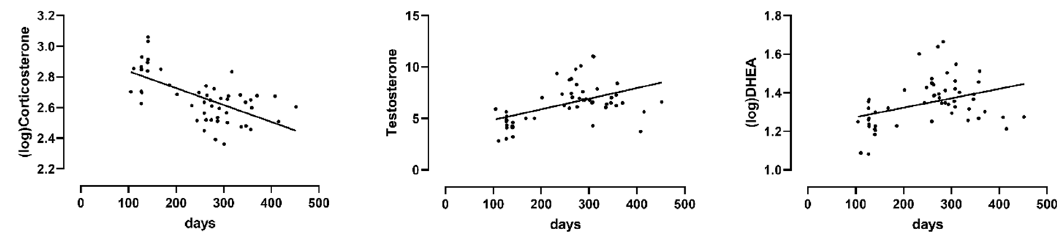
( p = 0.0377, Student’s t test) while CORT ( p = 0.3979, Welch test) and T ( p = 0.5446, Student’s t test)